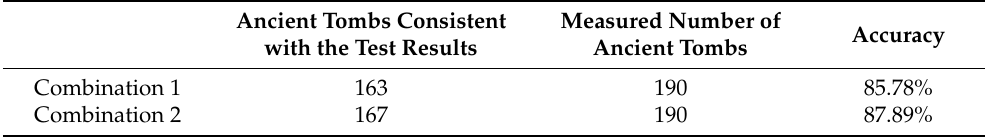
Table 7. Ground validation